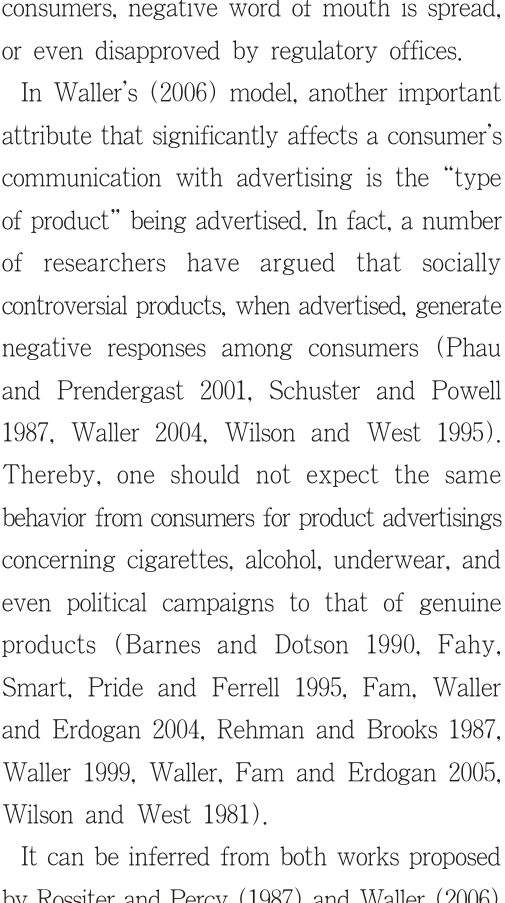
for controversial